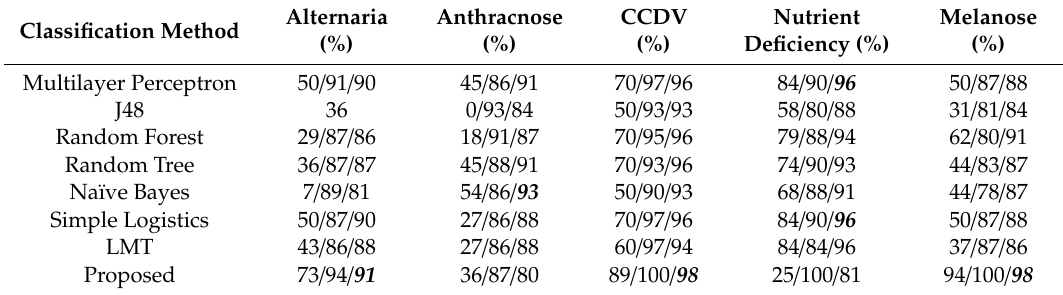
Table 7. Sensitivity / specificity / accuracy of the classification methods listed in the 1 st column, using the features presented in Table 1 (group B). The classification method with the best accuracy for each disease is highlighted with